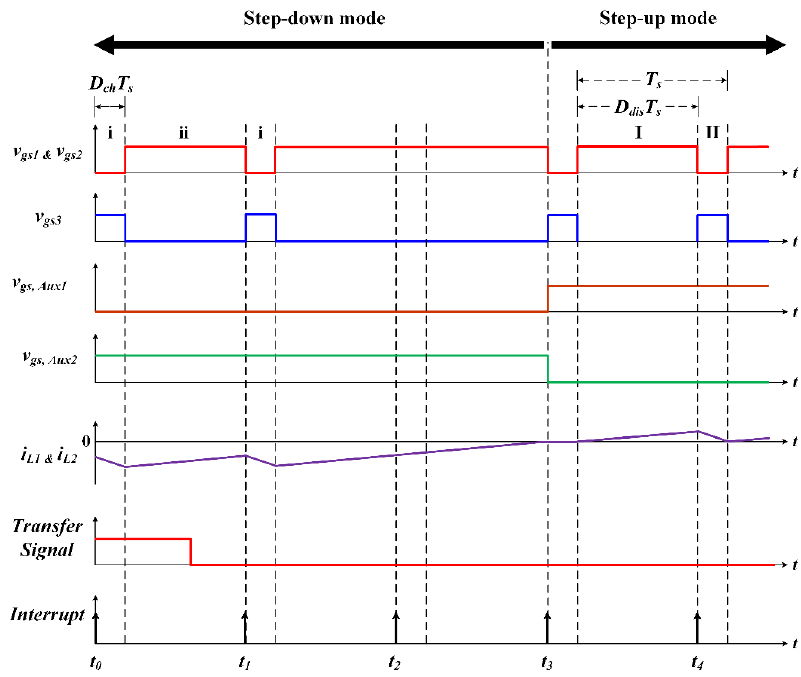
Figure 10. Timing of the transferring state from step-down mode to step-up